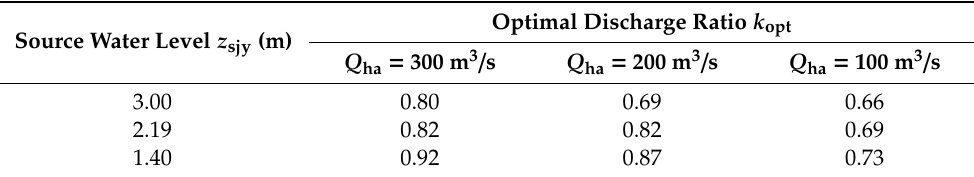
Figure 7. Relation between discharge distribution ratio and system input power. ( a ) Q ha = 300 m 3 /s; ( b ) Q ha = 200 m 3 /s; ( c ) Q ha = 100 m 3 /s. Table 4. Optimal discharge ratio k opt.